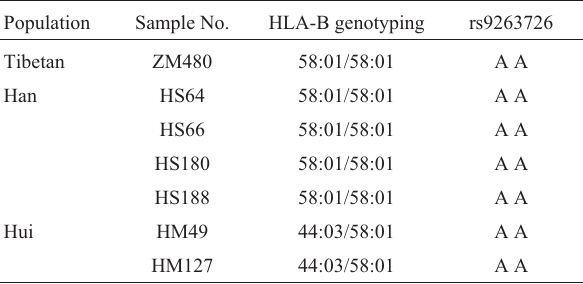
Table4 -HLA-BgenotypingofAAhomozygotesamplesinthethreepop- ulations. Population Sample